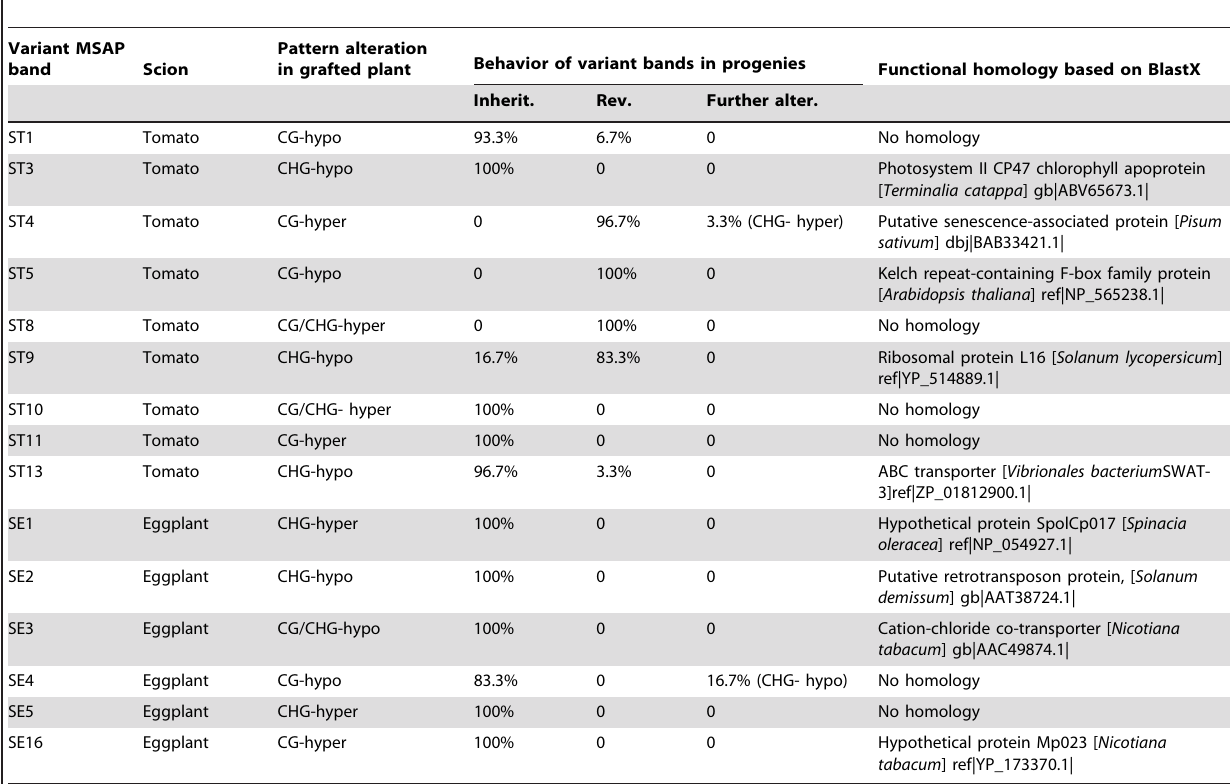
Table 2. Altered DNA methylation patterns of 15 variant MSAP bands in the grafted tomato or eggplant scions, their predicted functional homology and their inheritance to selfed progenies.